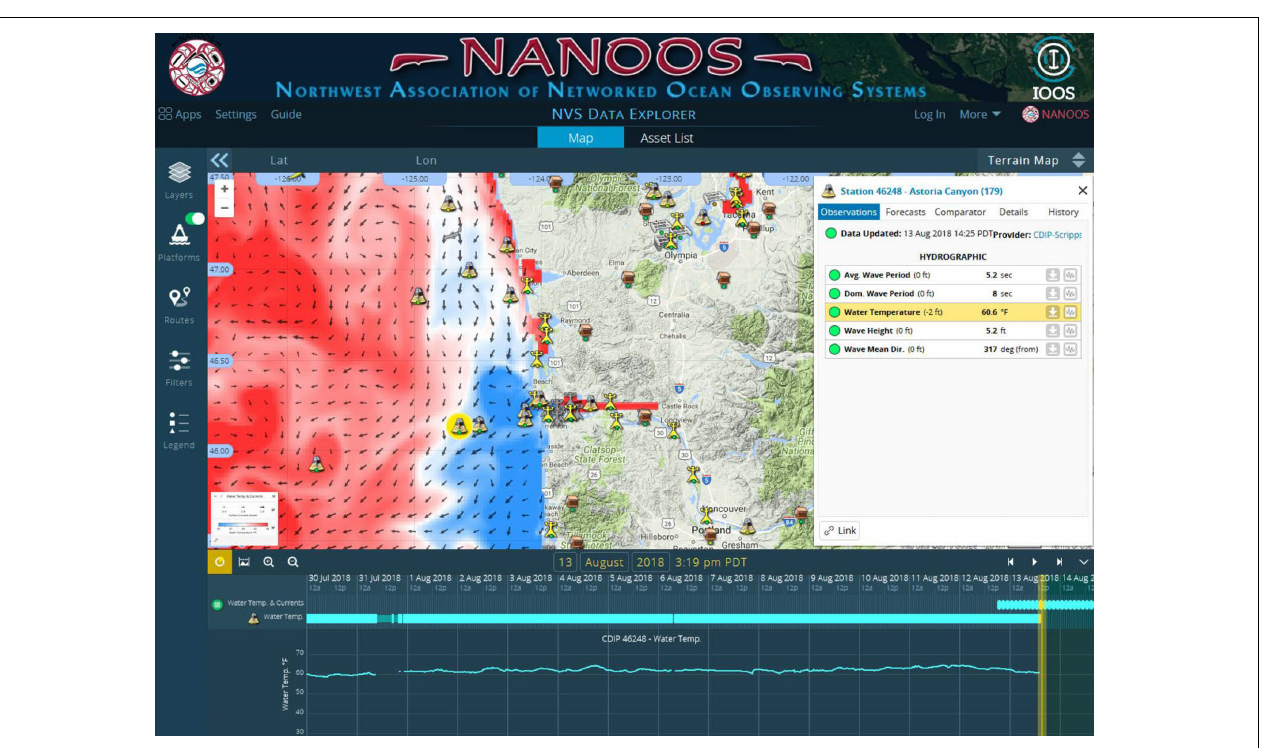
FIGURE 10 | The (NANOOS) Visualization System data portal for the US Pacific Northwest. Shown is Oregon State University Regional Ocean Modeling System (ROMS) model output for surface water temperature and currents, along with near real-time buoy data readings for several variables, including surface water temperature. Source: NANOOS